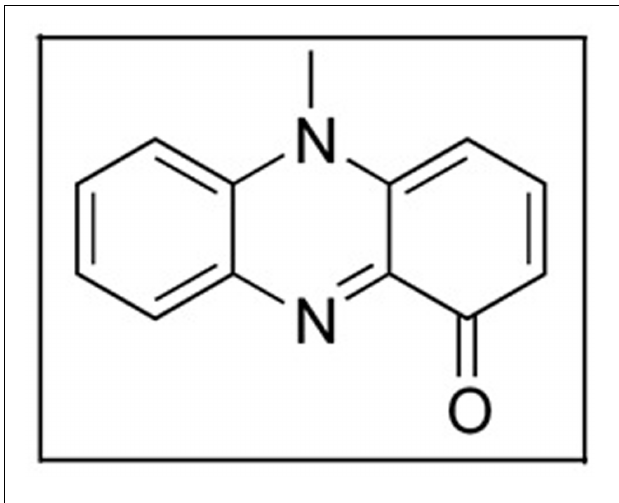
FIGURE 4 | Structure of